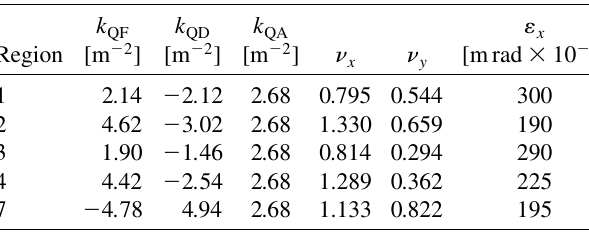
TABLE II. Lattice parameters for displayed CAMD